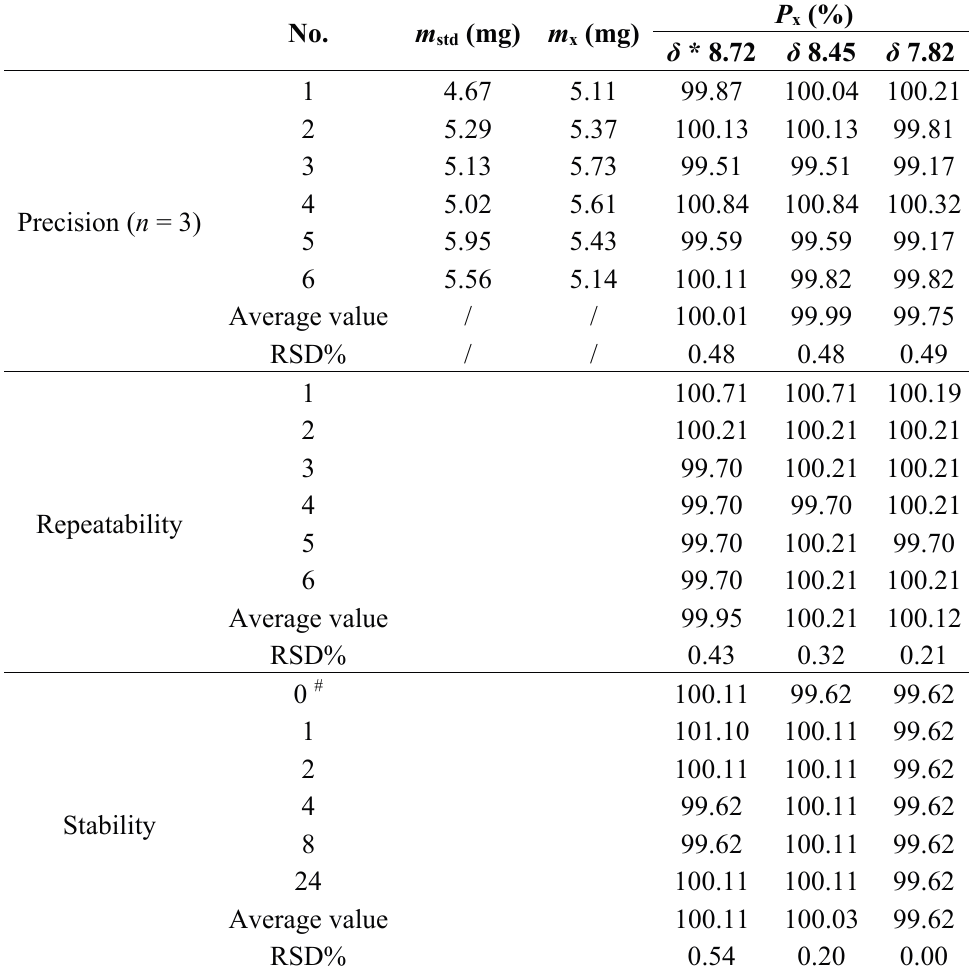
Table 2. Precision and stability of tadalafil by